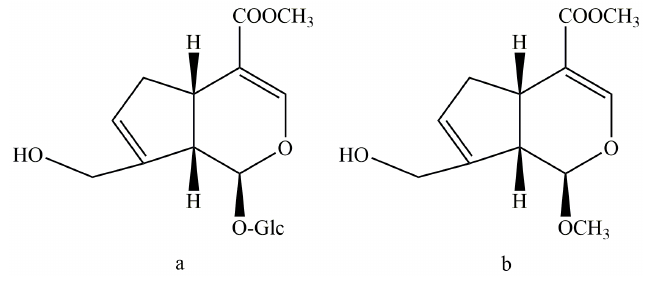
Figure 1. The Structure of ( a ) Geniposide (GE); and ( b ) Methyl genipin (MG).